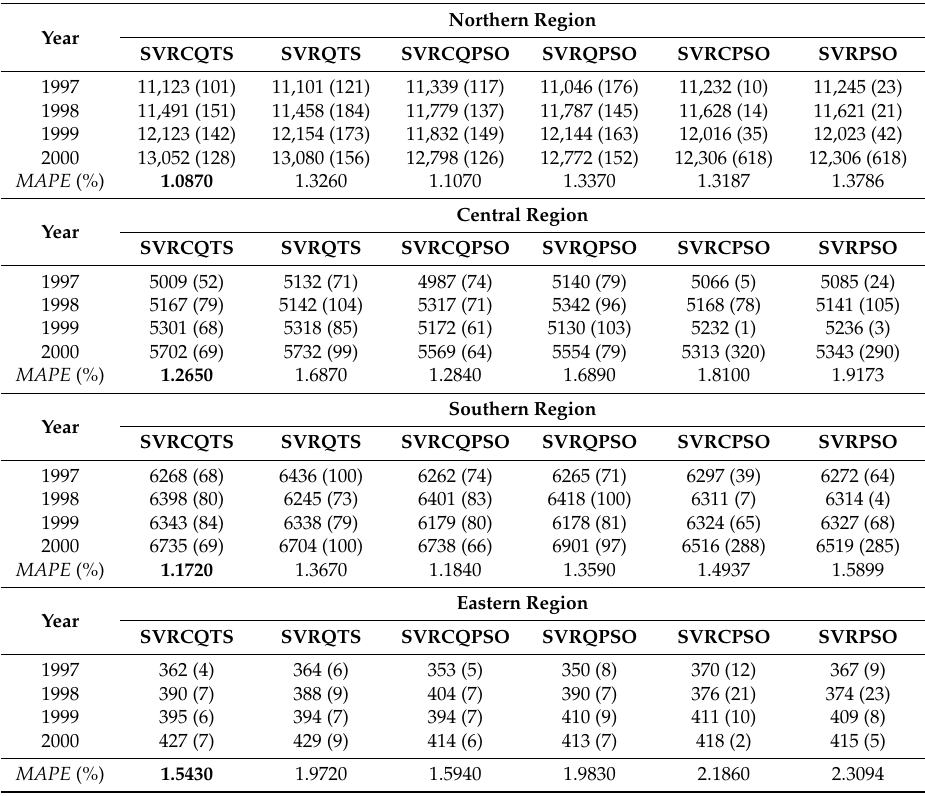
Table 2. Forecasting results (and absolute errors) of SVRCQTS, SVRQTS, and other models (example 1) (unit: 10 6 Wh).